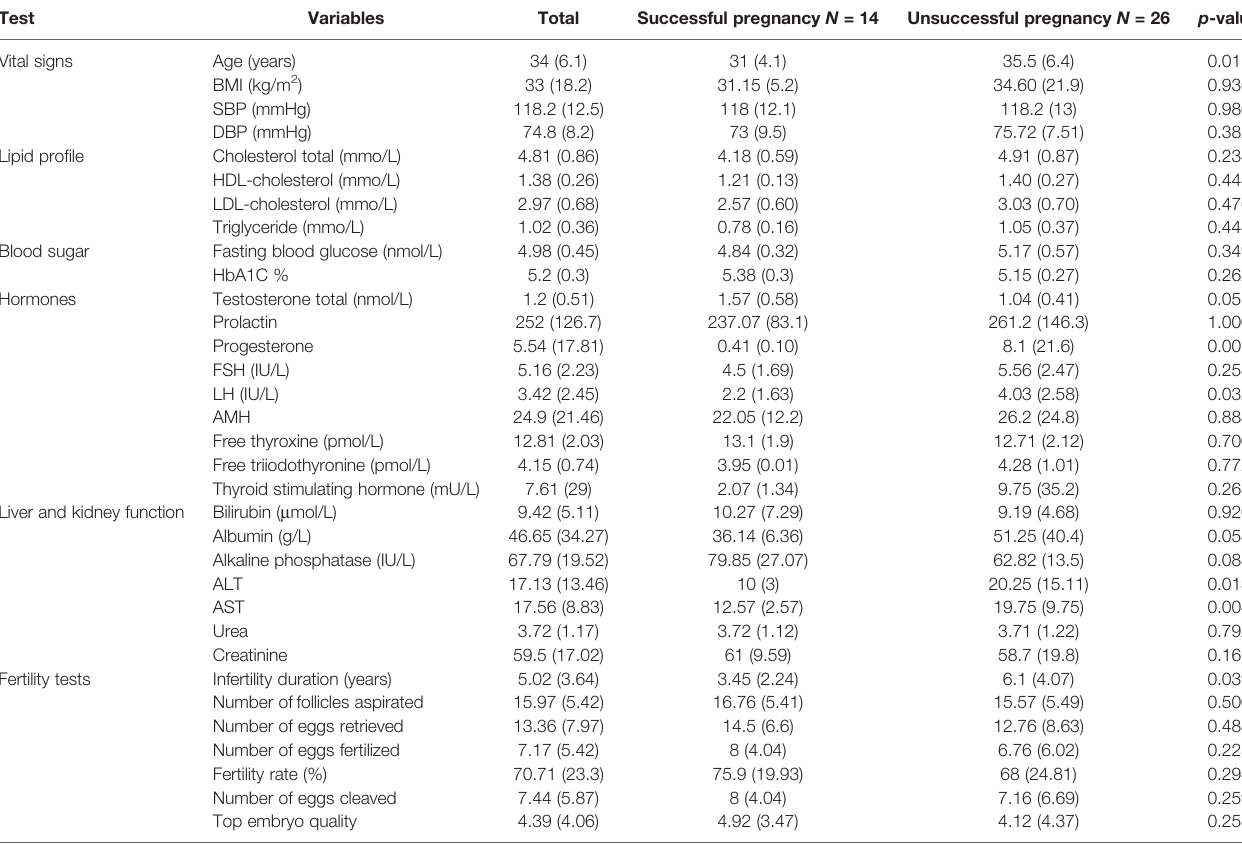
TABLE 1 | General characteristics of participants with successful or unsuccessful